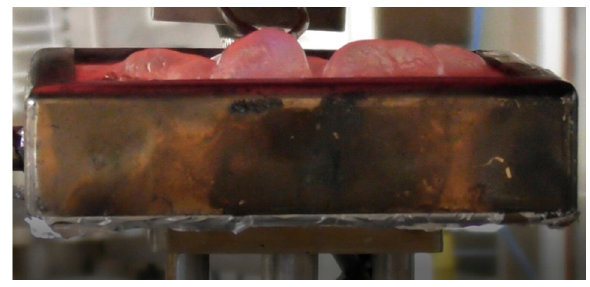
Figure 6. The behaviour of the coating based on starch acting as a blowing agent, heat flux 35 kW/m 2 , 20 s before the ignition.